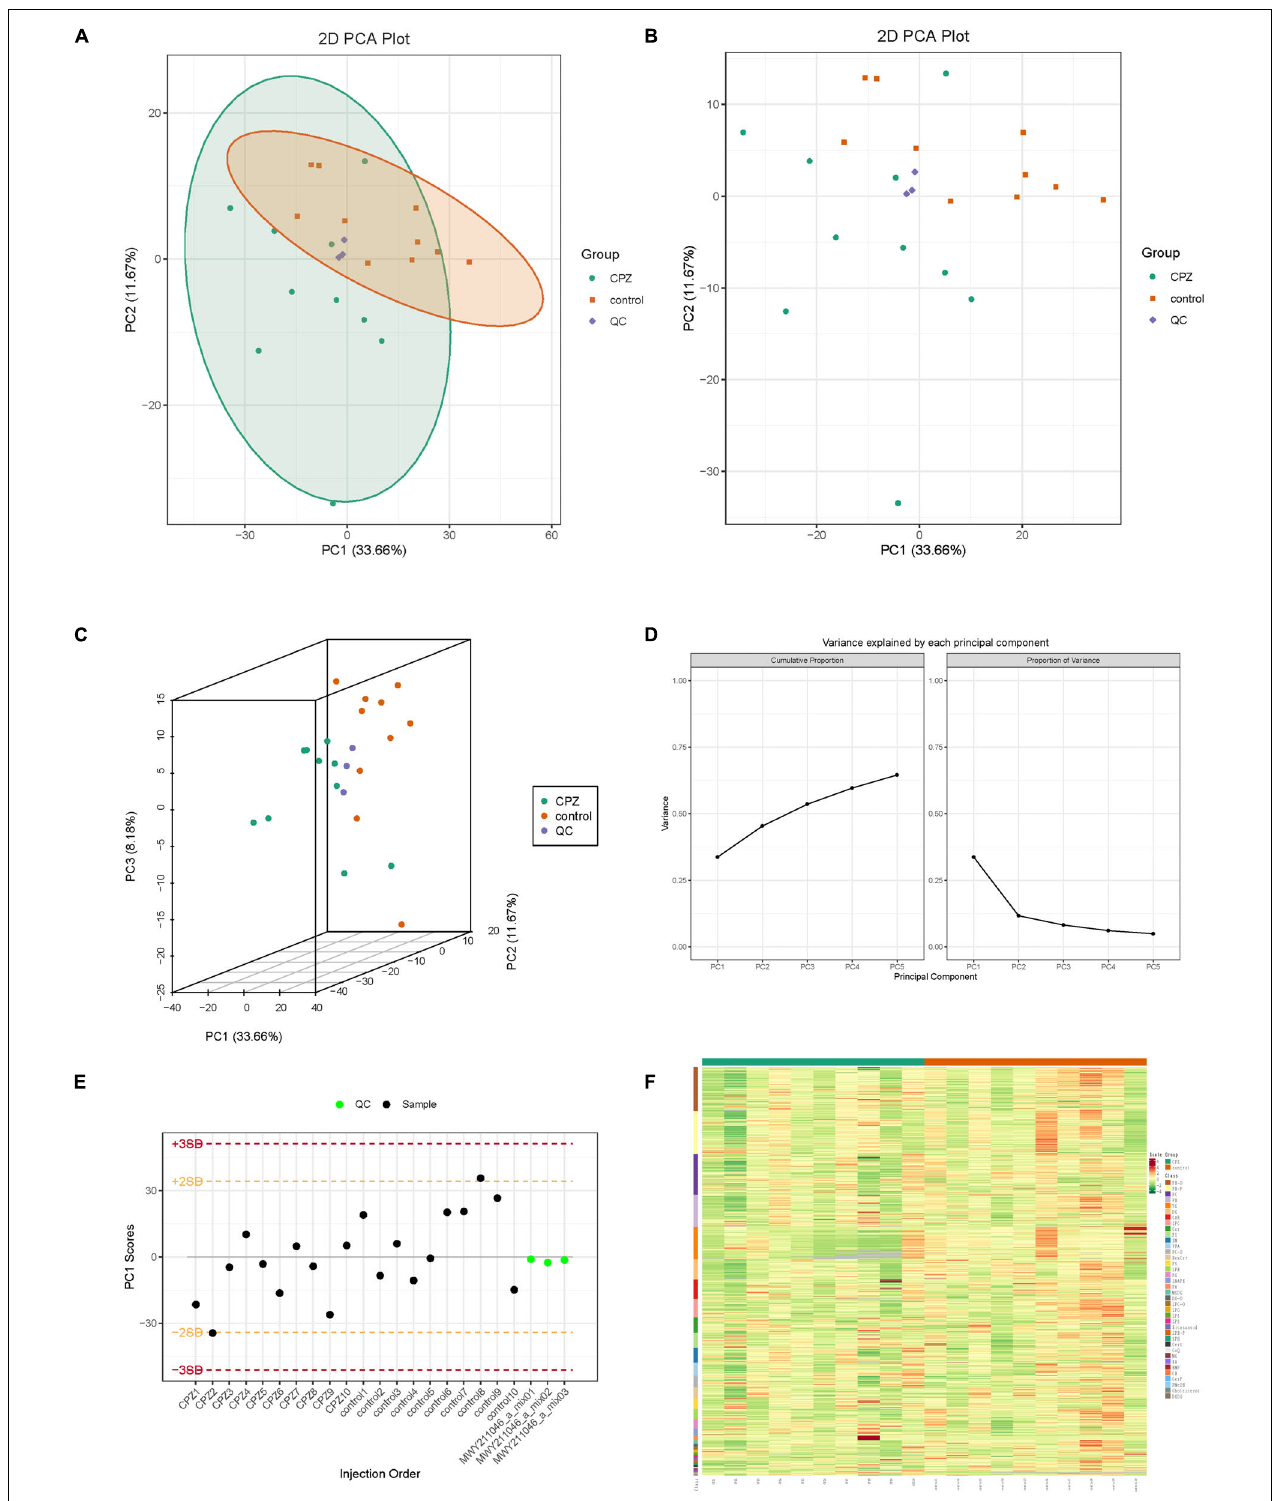
FIGURE 2 | (A,B) The two-dimensional images of the overall samples PCA results. (C) The 3D images of the overall samples PCA results. (D) The plot of variance explained by each principal component. (E) The plot of principal component univariate statistical process control, the horizontal coordinates of the graph are the order of sample testing, the vertical coordinates reflect the values of PC1, and the yellow and red lines define the plus or minus 2 and 3 standard deviation ranges, respectively. The green dots represent QC samples, and the black dots represent test samples. (F) Cluster Analysis of Lipidomics.